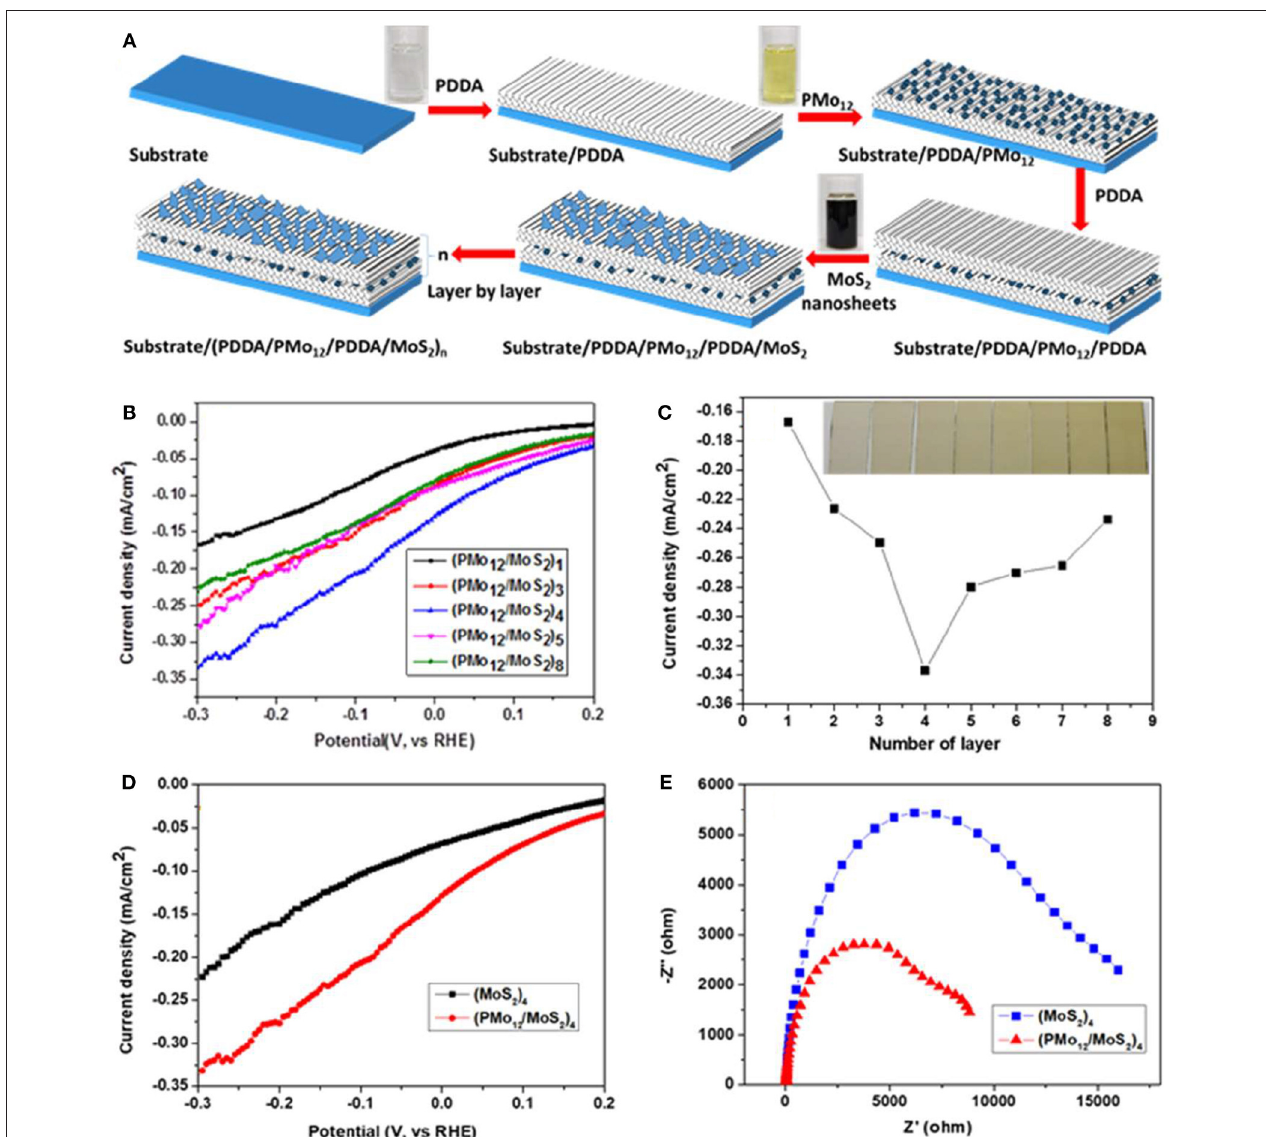
FIGURE 2 | (A) Process for building up the multilayer films (PMo 12 /MoS 2 ) n , (B) Polarization curves of multilayer (PMo 12 /MoS 2 ) n , (C) Current density as a function of layer number (inset of (c) Photograph of thin films of (PMo 12 /MoS 2 ) n deposited on ITO with different number of layer), (D) Polarization curves of multilayer (PMo 12 /MoS 2 ) 4 and (MoS 2 ) 4 , (E) The EIS spectra of multilayer (PMo 12 /MoS 2 ) 4 and (MoS 2 ) 4 (Huang et al., 2018a).